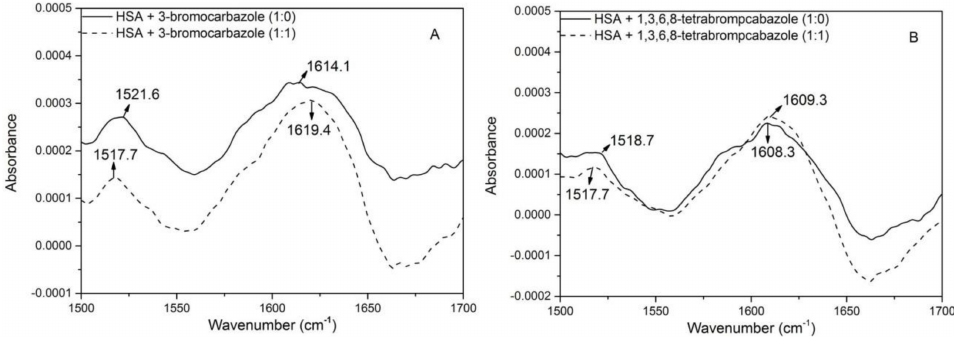
Figure 5. FTIR spectra ( A ): HSA-3-bromocarbazol; ( B ): HSA-1,3,6,8-tetrabromocarbazole): C HSA = 2.0 × 10 − 6 M, and the molar ratios of HSA-3-bromocarbazol and HSA-1,3,6,8-tetrabromocarbazole systems were 1:0, 1:1, and 1:2, respectively.